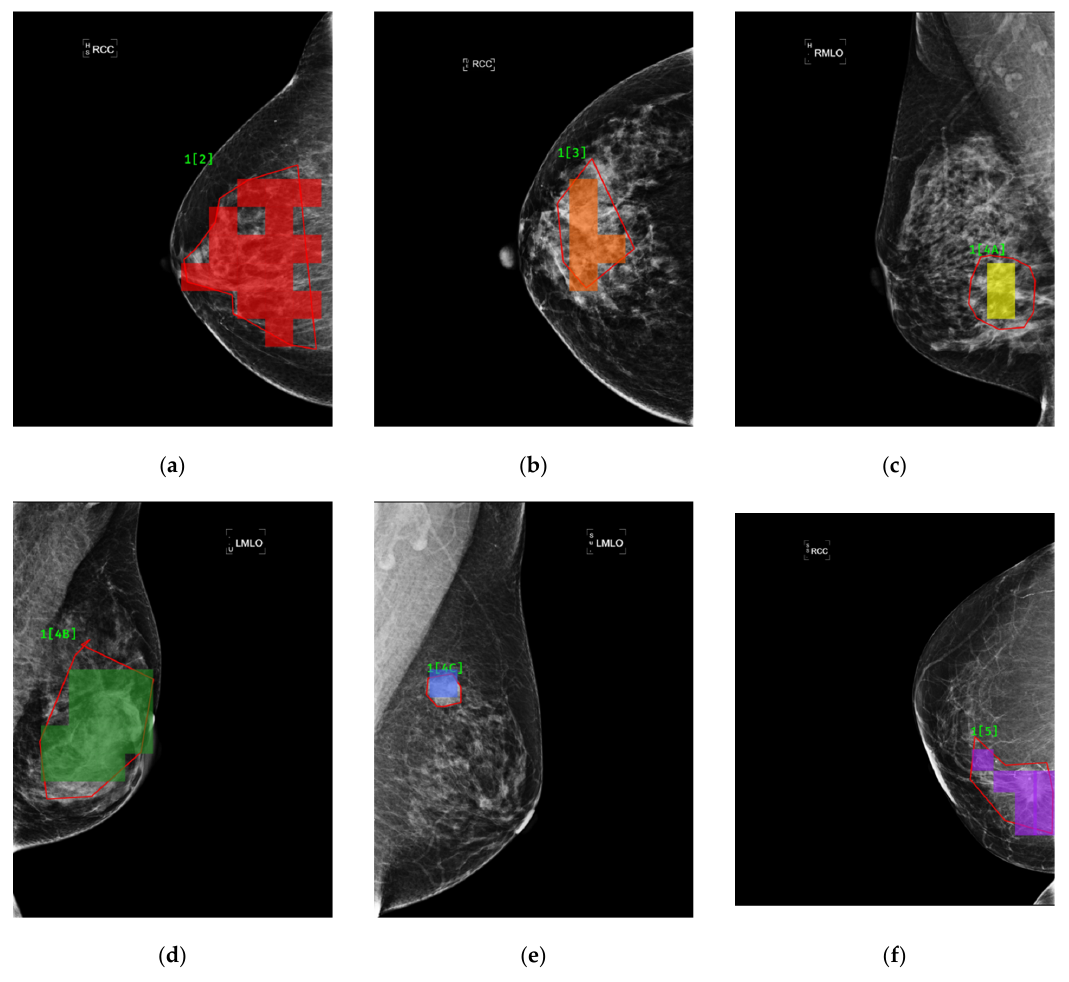
Figure 11. Comparisons between findings labeled by radiologists (framed in red) and highlighted in color in the cases of BI-RADS category 2, 3, 4A, 4B, 4C and 5 lesions in ( a – f ), respectively. Table 7. Task and performance comparisons between the presented study and previous studies on breast cancer